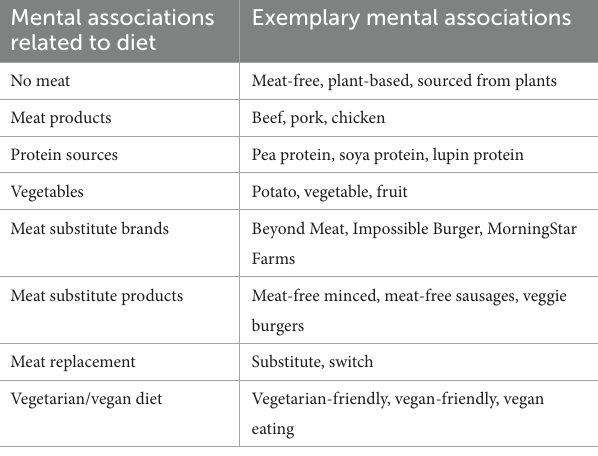
TABLE 1 Mental associations related to